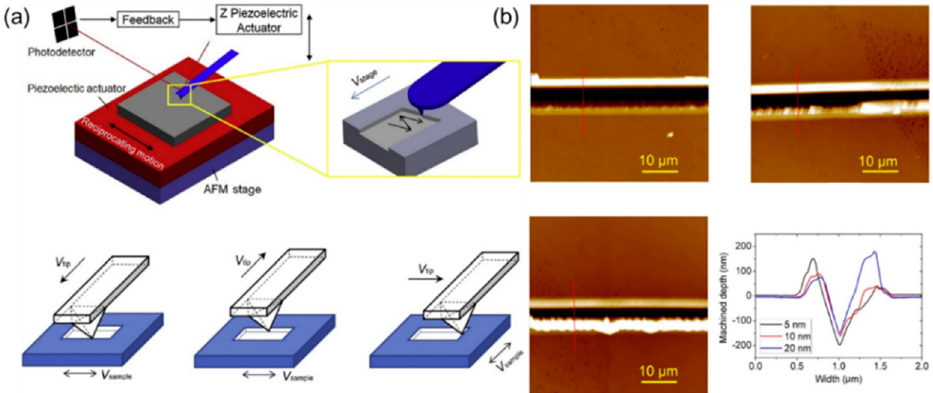
Figure 11. ( a ) The schematic diagram of fabricating nanogrooves using the combination of the TBN method and reciprocating motion, ( b ) nanogrooves obtained by the approach of ( a ) [89] .